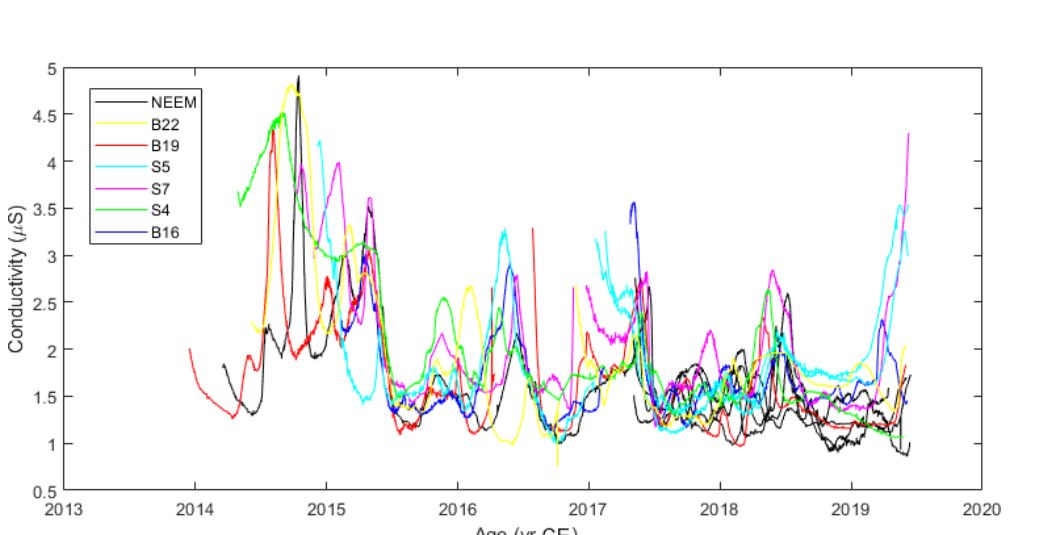
Figure 4. Conductivity for seven sites in northern Greenland on an age scale. Note the high values centred on winter 2015, likely reflecting the eruption of the Holuhraun vent of Bárðarbunga Volcano in Iceland (29 August 2014 to 27 February 2015) (Du et al., 2019a; Schmidt et al., 2015; Gauthier et al.,